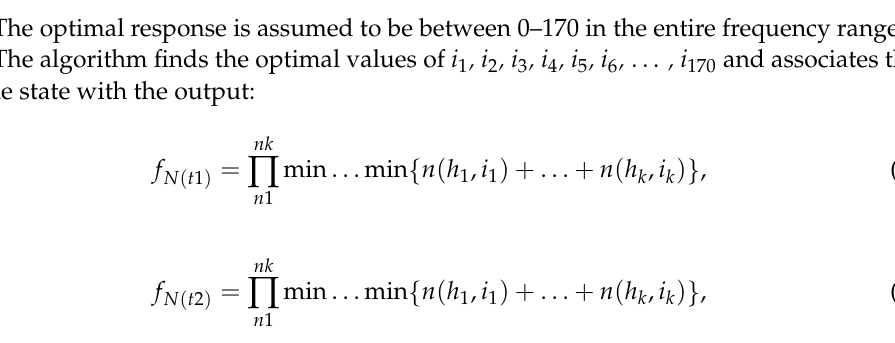
Figure 11. Inductive decision trees for t 1, where C—efficient engine, NI—injection inefficient, and UC—pressure inefficient.